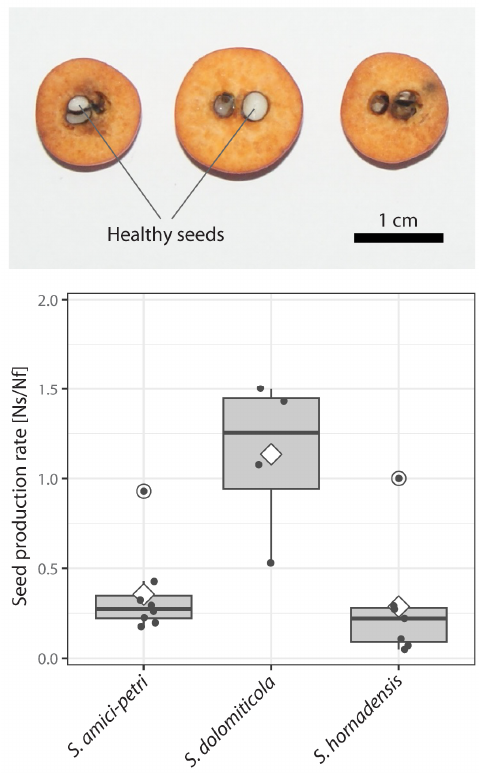
Figure 3. Seed production rate in polyploids Sorbus amici-petri , S. dolomiticola , and S. hornadensis . Examples of three halved fruits ( S. amici-petri , basal halves) with well-developed seeds (upper subfigure). Variation in seed production rate (lower subfigure); dots represent seed production rate of individual trees; the lower and upper hinges of boxplot correspond to the first and third quartiles (delimit inter-quartile range; IQR), whiskers extend to ±1.5 × IQR, and empty circles represent outliers; horizontal lines and diamonds represent median and mean values, respectively. Ns–number of well-developed seeds, Nf–number of examined